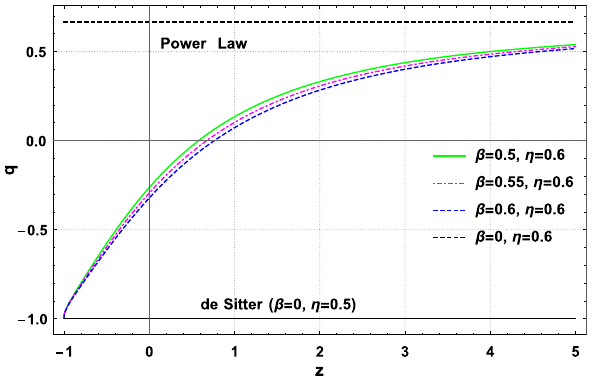
Fig. 1 Variation of deceleration parameter q against redshift z